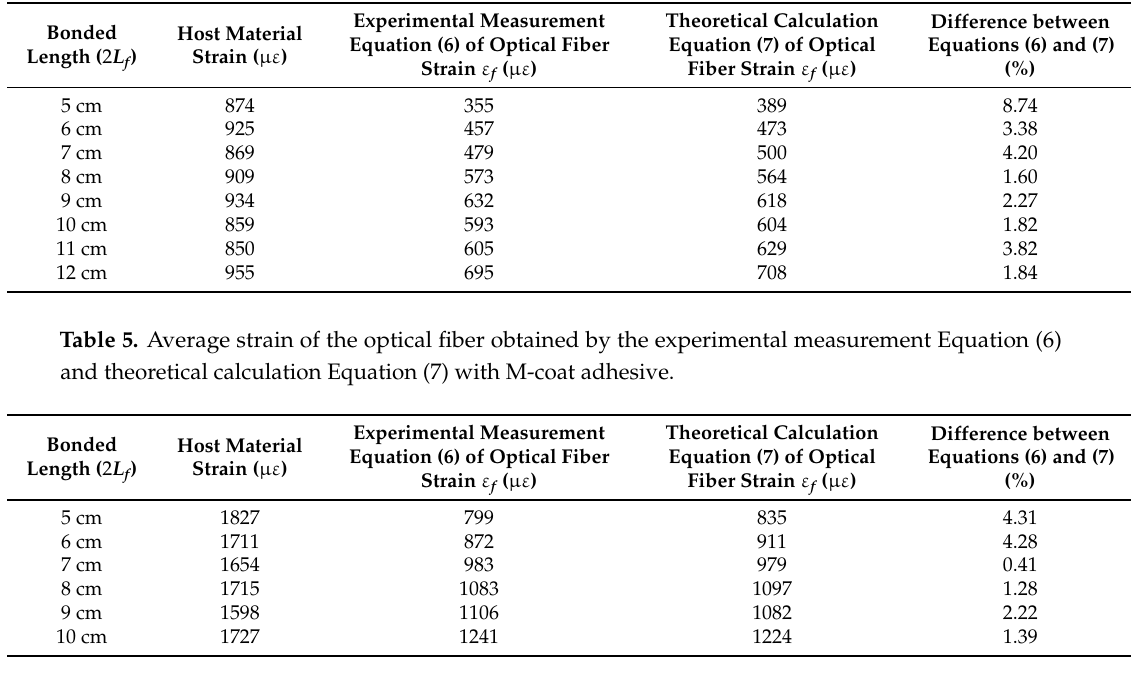
Table 4. Average strain of the optical fiber obtained by the experimental measurement Equation (6) and theoretical calculation Equation (7) with acrylate adhesive.